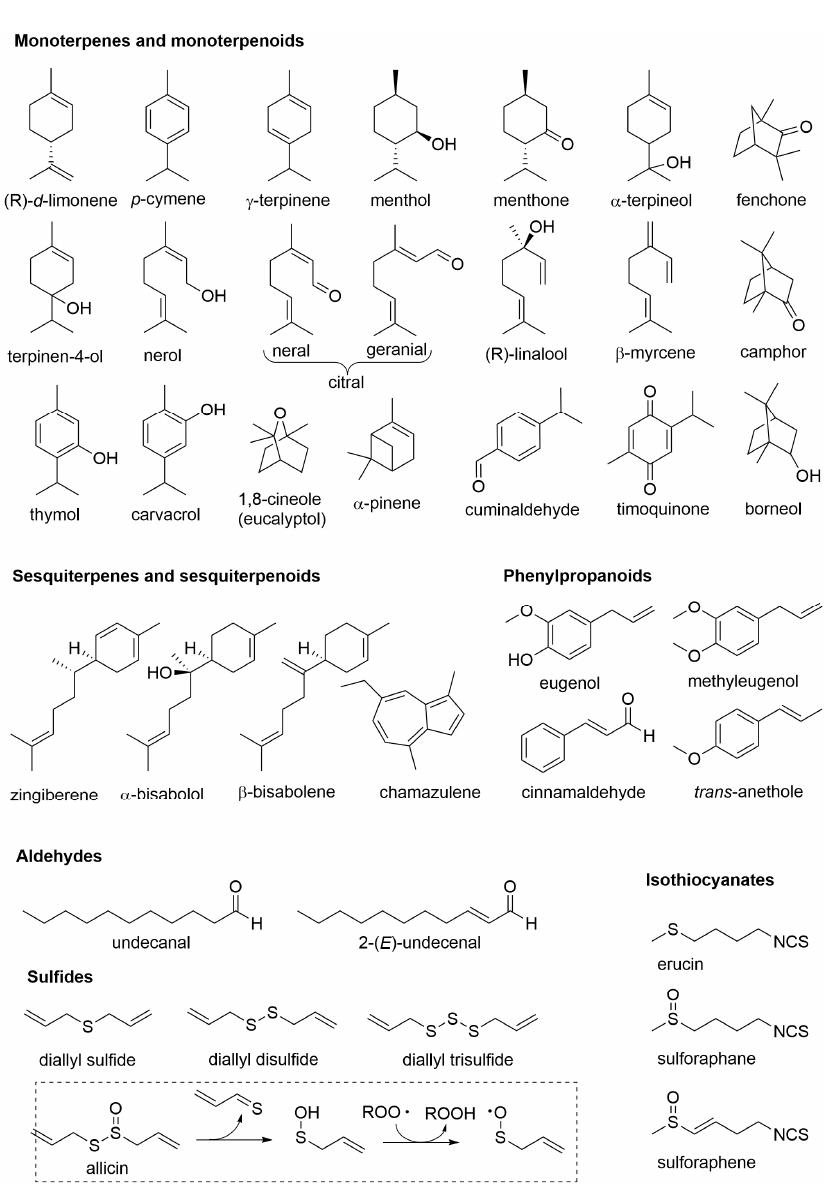
Figure 2. Examples of typical EO components classified by the structural family.